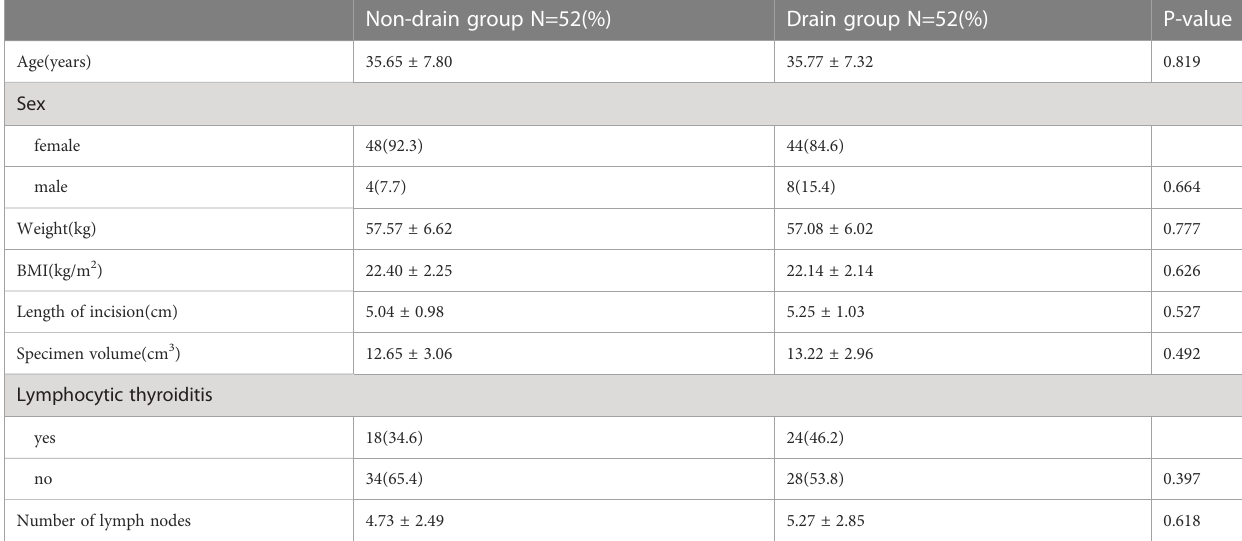
TABLE 1 Comparison of general information and pathological information between the non-drainage and drainage